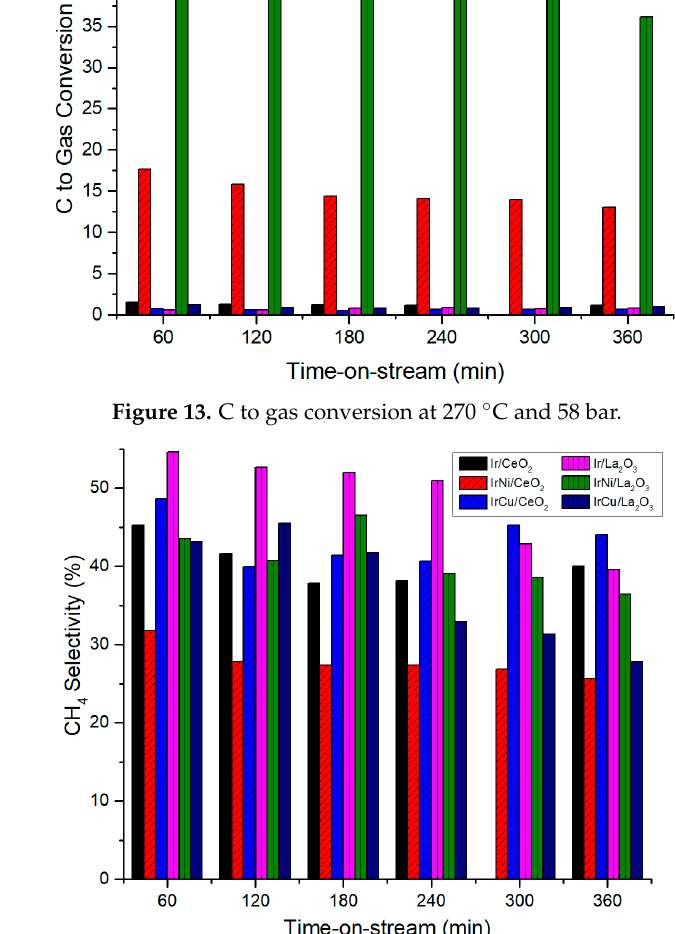
◦ C and 58 Figure 14. CH 4 Selectivity at 270 °C and 58 bar. Figure 14. CH 4 Selectivity at 270 Figure 14. CH 4 Selectivity at 270 °C and 58 bar. Figure 14. CH 4 Selectivity at 270 °C and 58 bar.